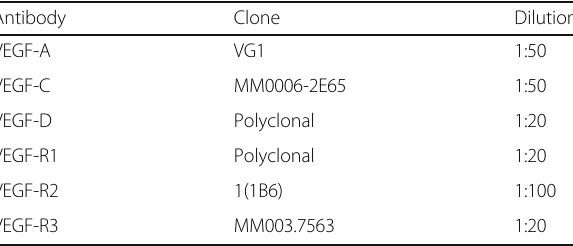
Table 1 Summary of antibodies ’ clones and titration Antibody Clone Dilution VEGF-A